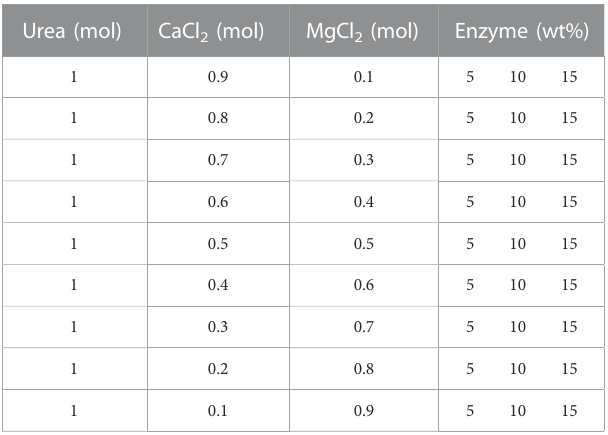
TABLE 2 Chemical formulation to estimate the synergistic effect of MgCl 2 and CaCl 2 at different concentrations of enzymes.